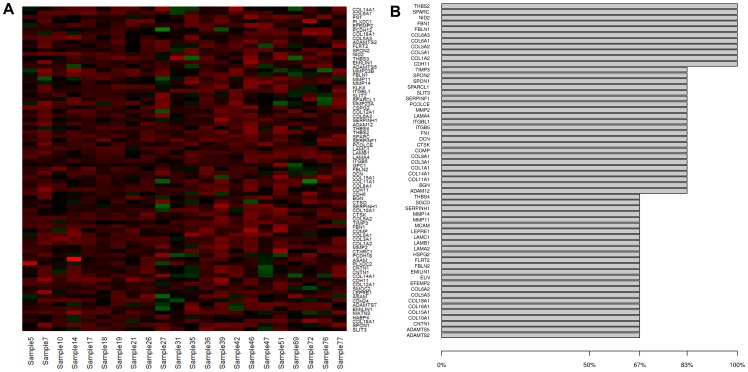
ECM3 gene pattern in breast carcinomas.(A) Expression profile of LAS biclustering in breast tumors from the Van't Veer dataset [15]. (B) Frequency distribution of most influential ECM3 genes in 6 datasets ([15]–[20]), tumor clustering and gene importance estimation.